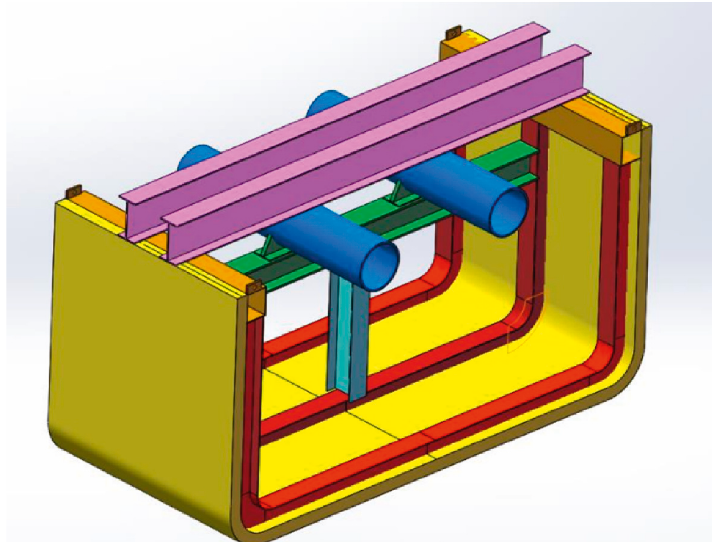
Figure 5: Backbone of the model in blue.